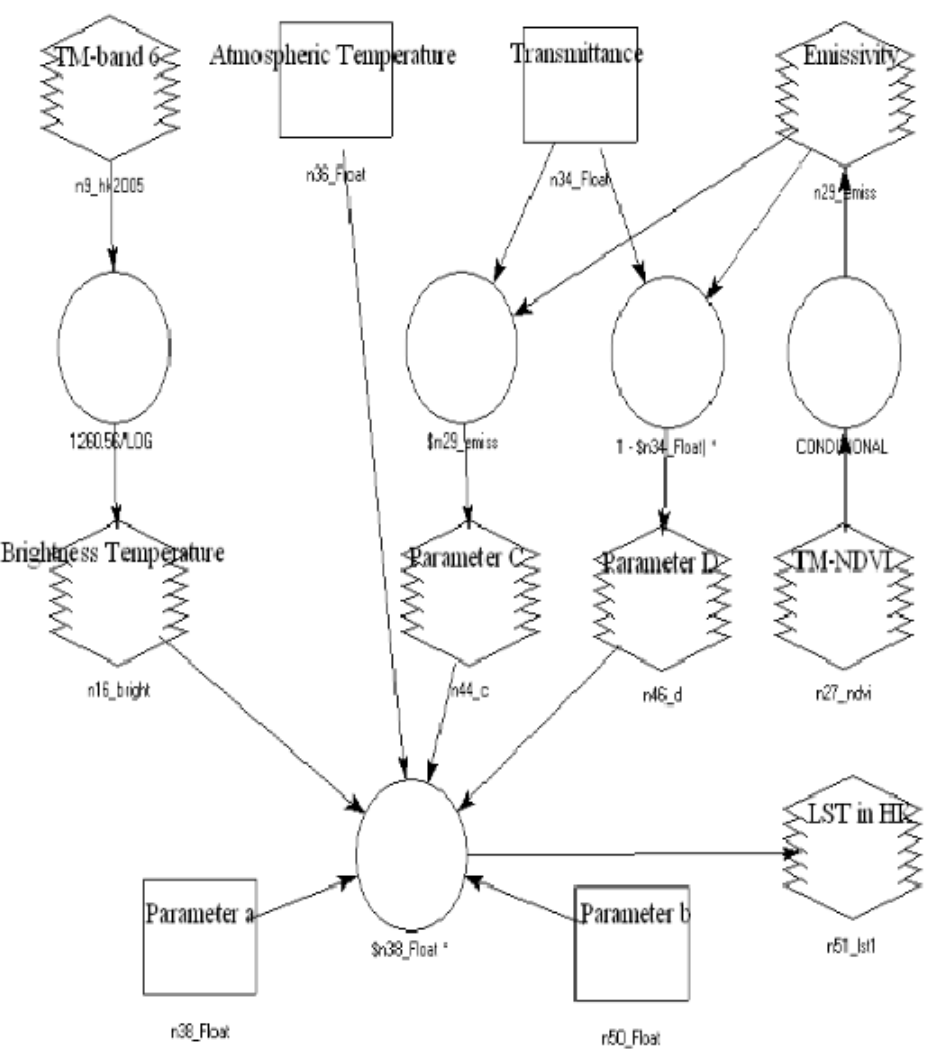
Figure 3. The flowchart of the mono-window